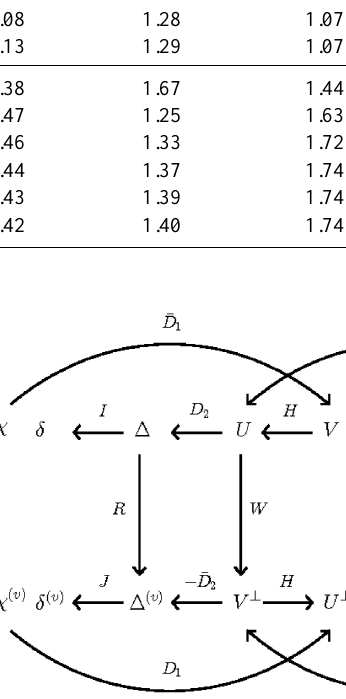
Figure 2. Schematic showing how the various mimetic operators map between the different fields used on the polygonal